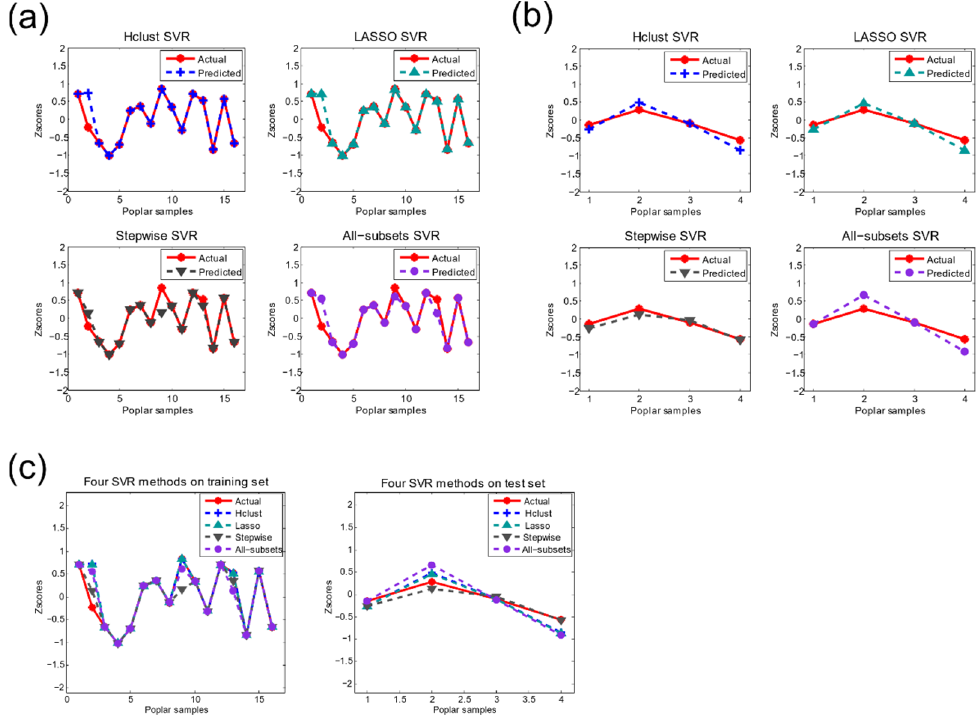
Figure 6. Regression results of four SVR methods on training set and test set. ( a ) Training set; ( b ) test set; ( c ) comparison between training set and test set.